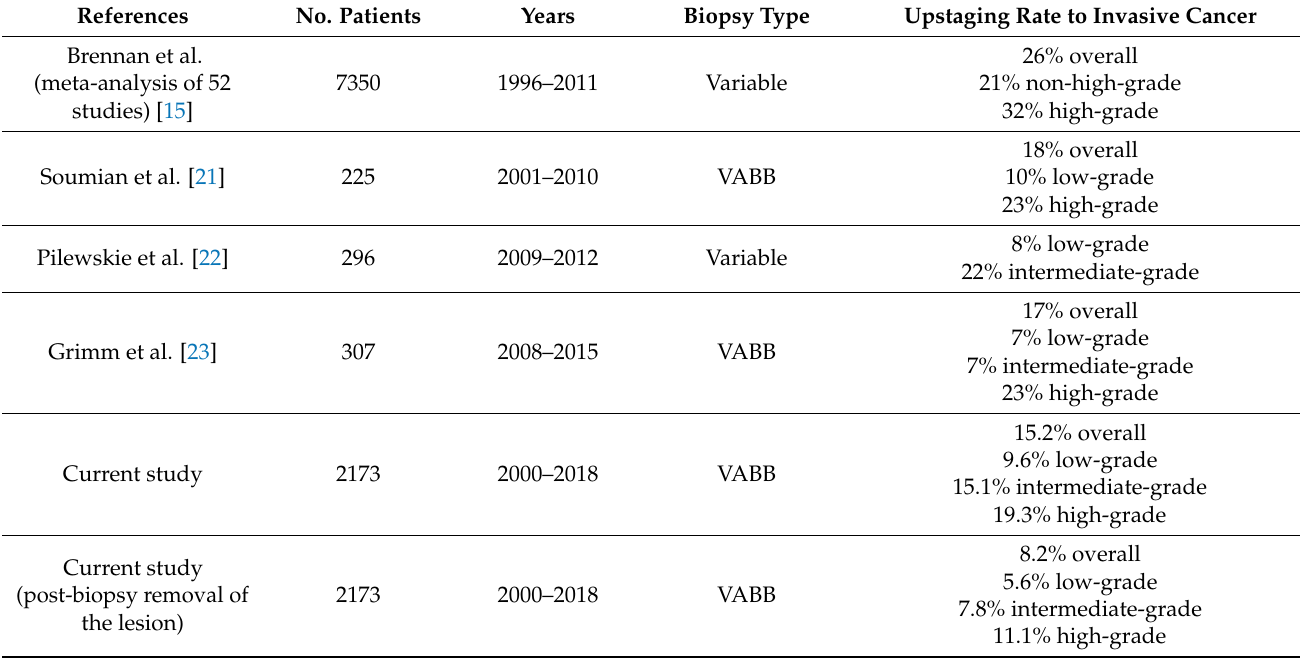
Table 4. Upgrading rates to invasive carcinoma of breast biopsies in different